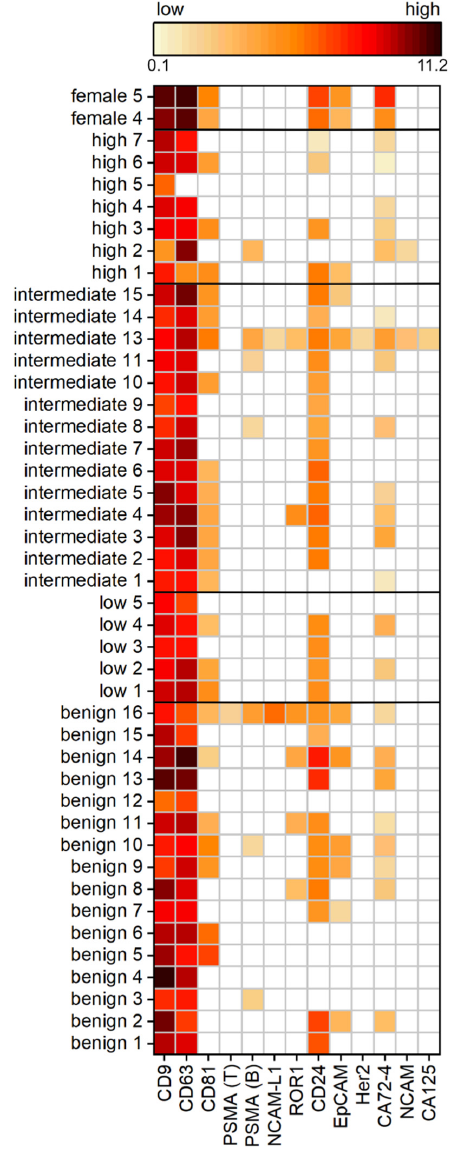
Figure 4. Expression analysis of uEV surface proteins of a PCa cohort with benign patients and patients with low, intermediate, and high risk according to the Gleason score, as well as healthy female controls by antibody microarray normalized to creatinine. The heat map displays log2 calculated background-subtracted values with no (white) and low (light orange) to high expression (dark red), n = 3.